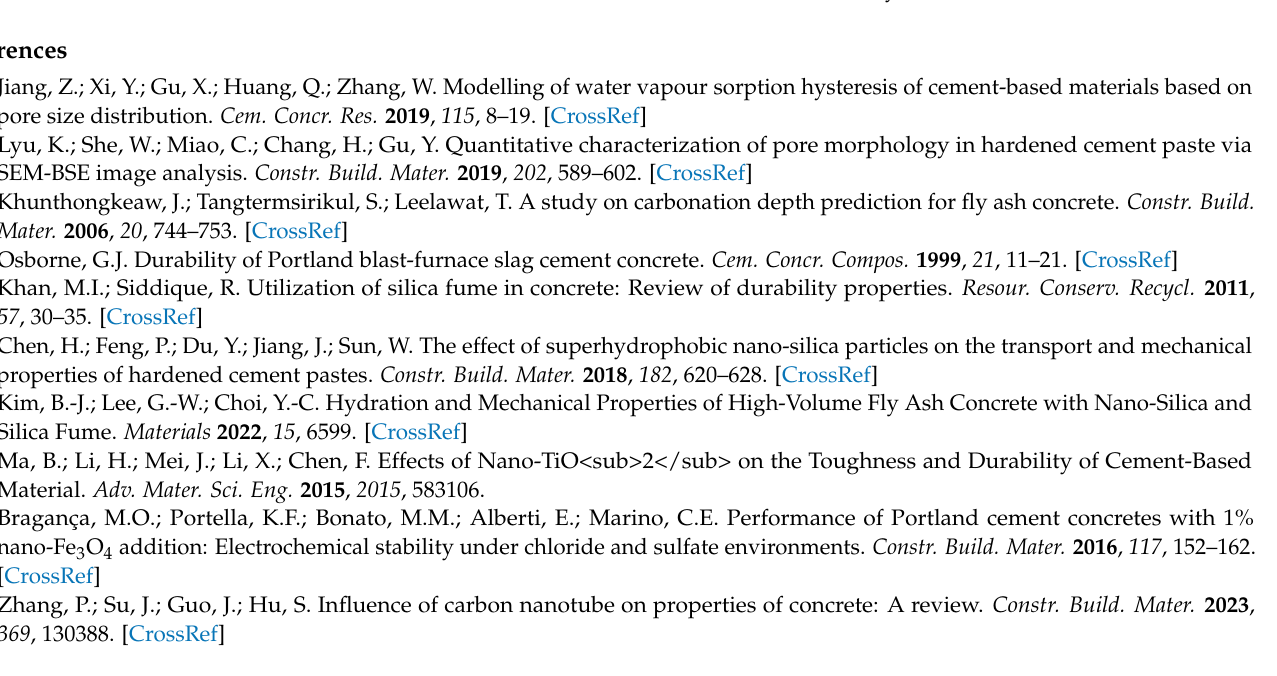
scattering. Figure S3: (a) The measured shear stress vs. shear rate and (b) shear viscosity vs. shear rate curves for studied cement pastes at the initial time. Figure S4: (a) BET surface area and (b) pore size distribution curves of control and BCP doped cement pastes samples at 28-days; Table S1. Chemical composition (wt%) of ordinary Portland cement (PO 42.5) used in this study. Table S2. Basic parameters of pore structure estimated from BET